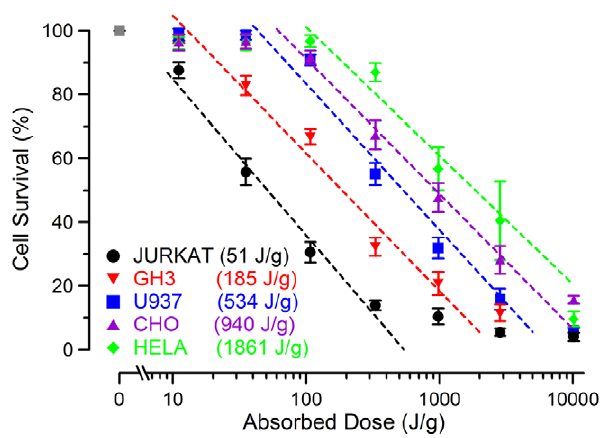
Figure 2. Cell survival as determined by dose in several cell types. Mean survival values ( + / 2 s.e., in % relative to sham-exposed control, n=3–5) are plotted against the dose delivered to the cuvette. Logarithmic fit lines (dashed) reveal significant differences between cell populations. LD 50 values (J/g) are displayed in the legend for each population as calculated using the logarithmic fit.